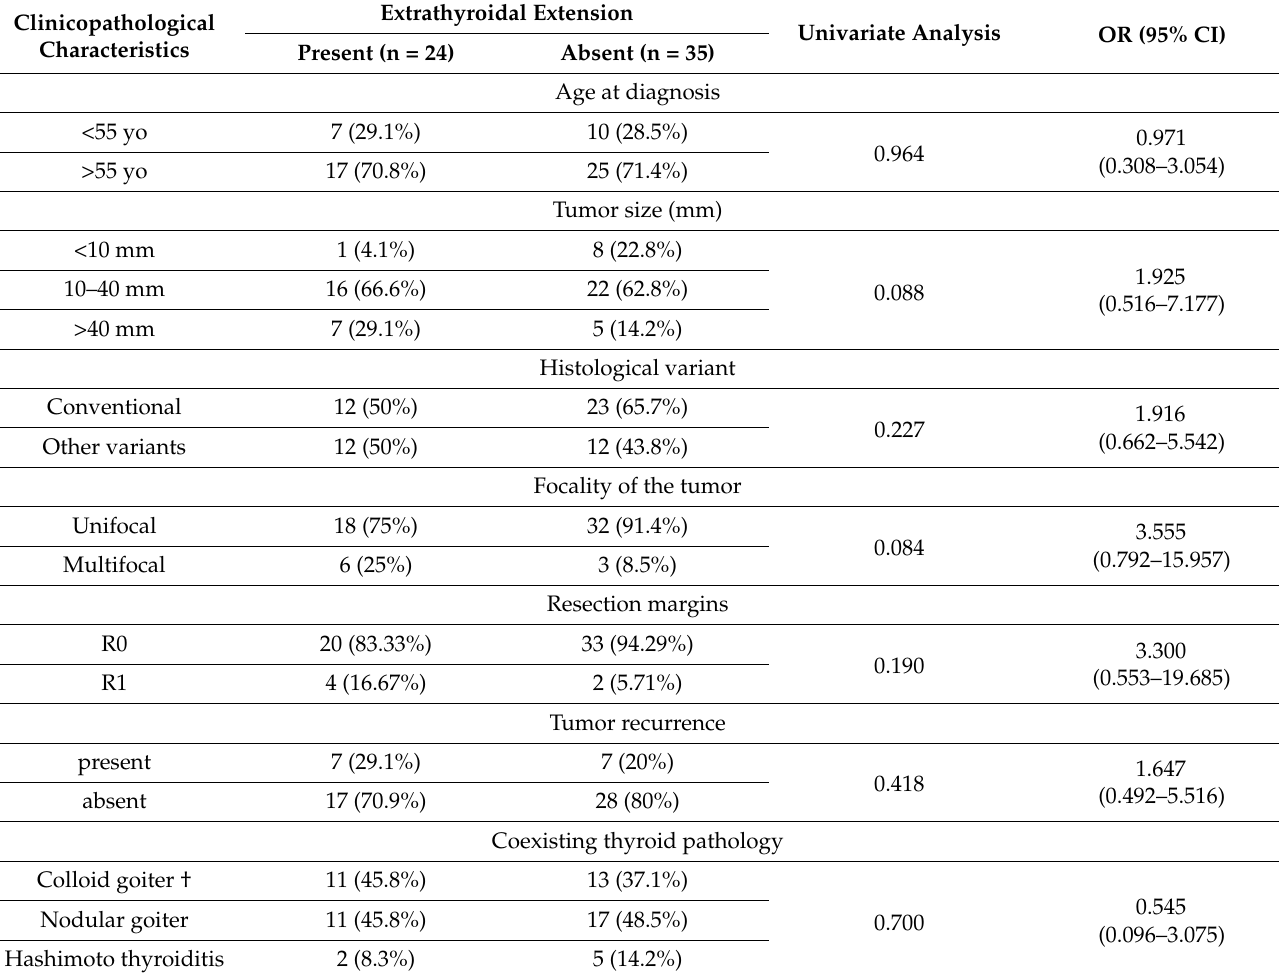
Table 4. Clinicopathological characteristics of MTC in relation to extrathyroidal